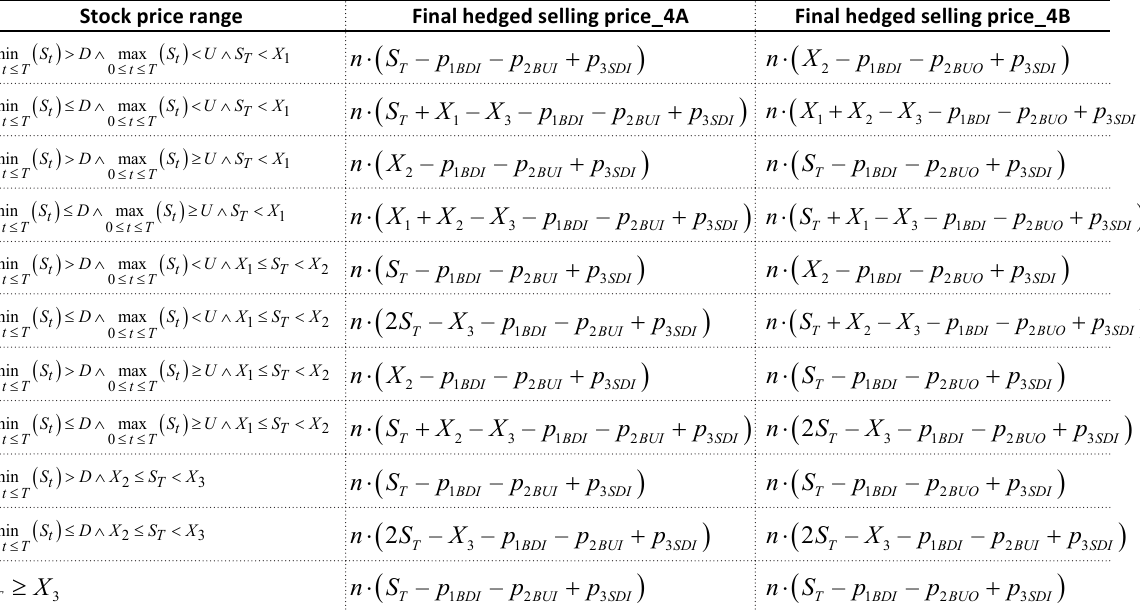
Source: Own design.